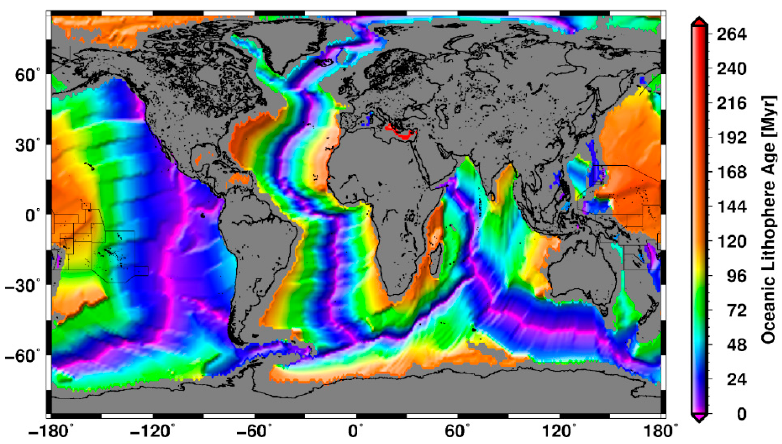
Figure 4. The age of the oceanic lithosphere according to [45].